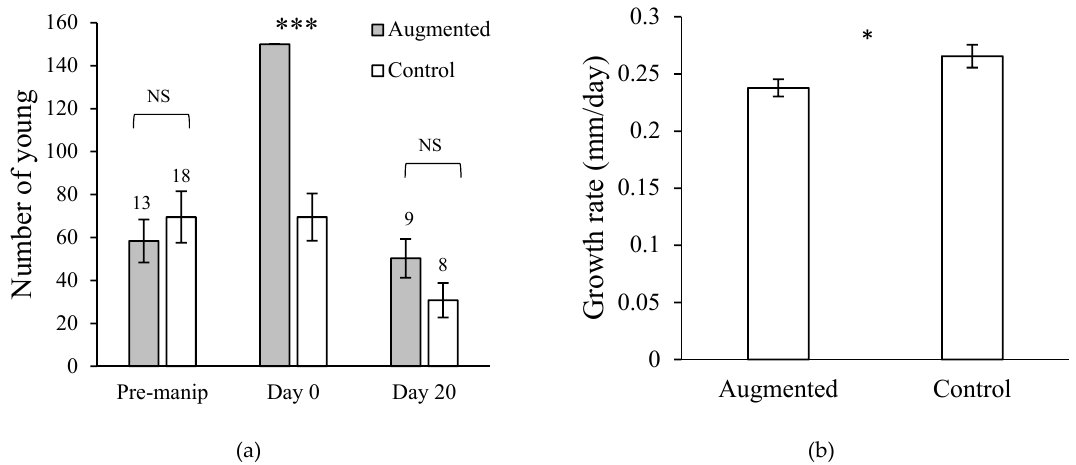
Figure 8. ( a ) Lack’s hypothesis is that maximum brood size is limited by the number of offspring that can be reared to independence, not by the physiological capacity to produce eggs. Naturally-occurring broods in the Río Cabuyo were either left unmanipulated (control) or augmented with extra fry to have 150 young. Experimental broods were unable to sustain numerical advantage of the manipulation by the end of 20 days. ( b ) Individual growth rates of larvae in experimental broods were significantly lower than larvae in control broods due to crowding within the parentally-defended area and therefore experienced increased competition for food. * p < 0.05, *** p < 0.001. Data from [ 18 ].